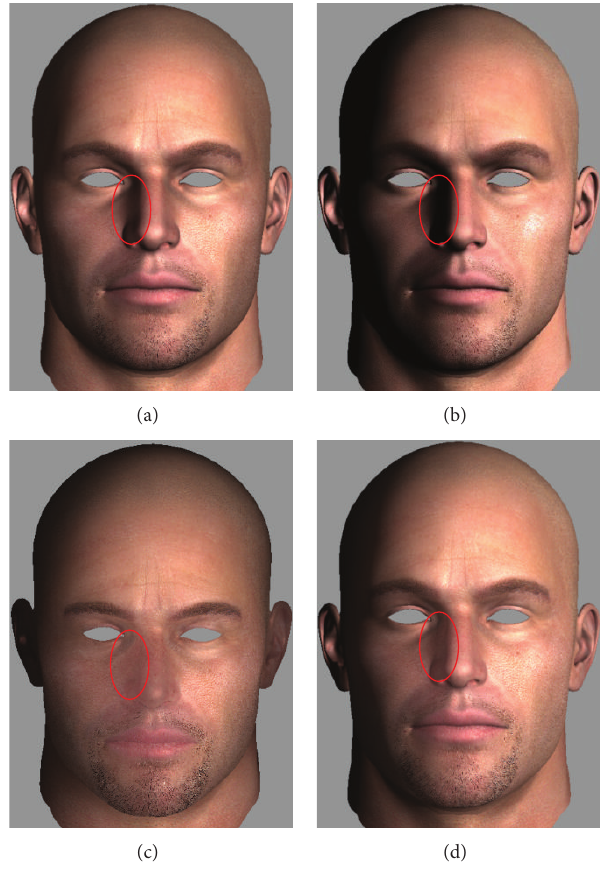
Figure 7: Rendering results of (a) Ward’s BRDF, (b) the layered Oren-Nayar BRDF, (c) Chang’s texture space BSSRDF, and (d) our real-time subsurface scattering